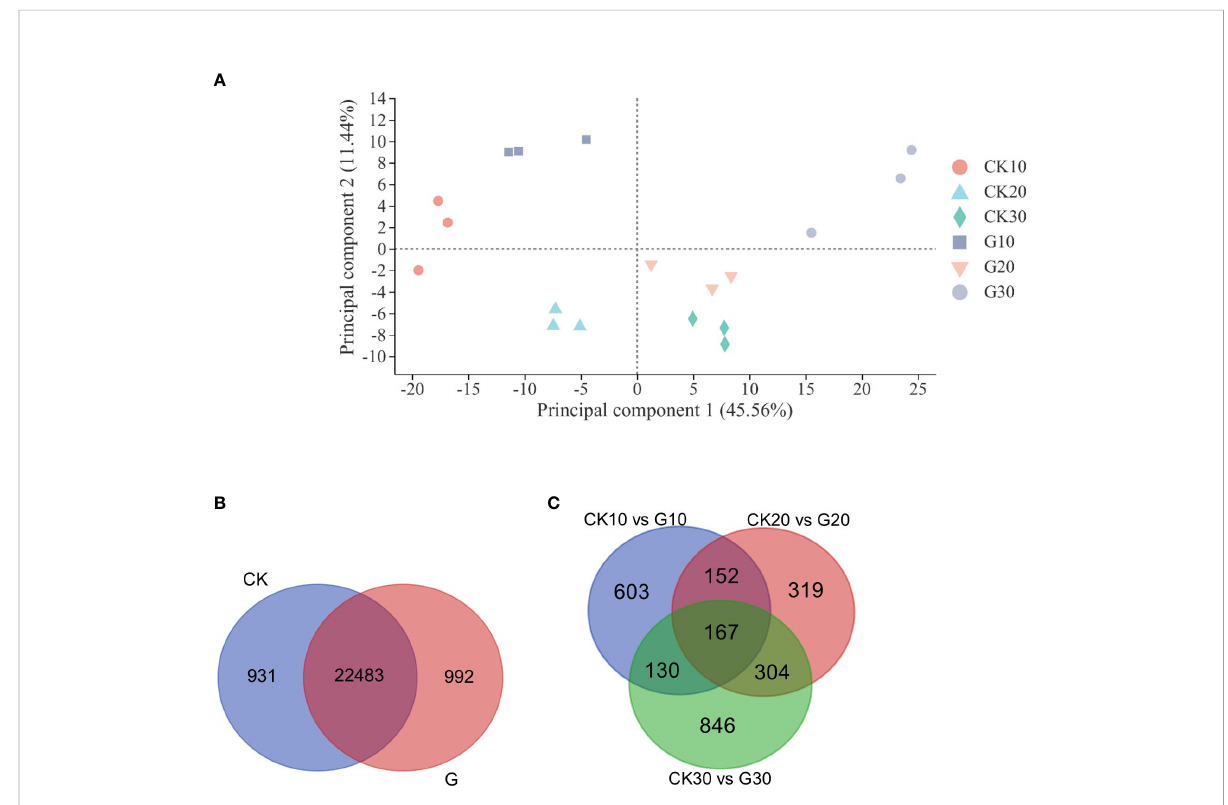
FIGURE 2 Principal component analysis and gene expression. (A) Principal component analysis of 18 RNA-seq libraries. TPM values were used in the analysis. (B) Venn diagram of expressed genes in girdling and control groups. (C) Venn diagram of DEGs between girdling and control groups at three different sampling times. TPM, transcript per million reads; DEGs, differentially expressed